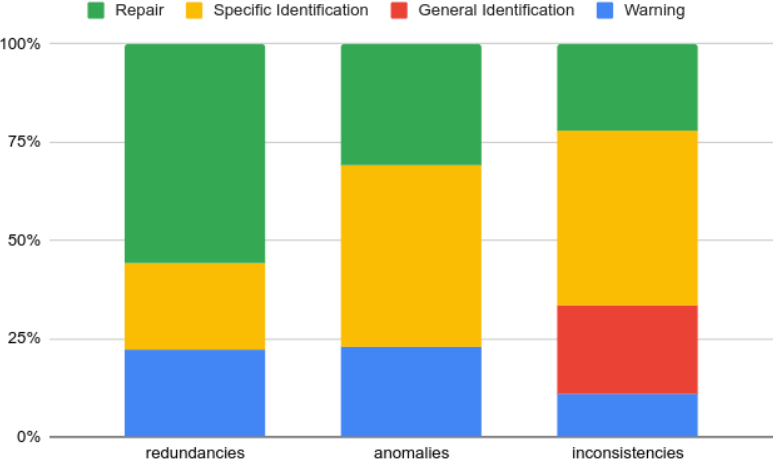
Figure 22. Summary of responses with respect to the severity